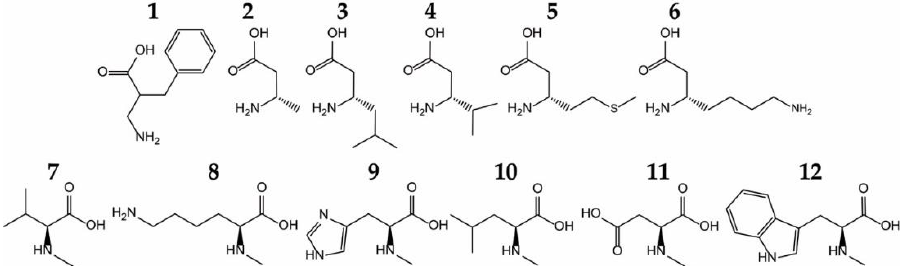
Figure 2. Examples of noncanonical amino acids (ncAAs) acylated by wild-type aaRSs in vitro. Phenylalanyl-tRNA synthetase (PheRS) acylates a β 2 -amino acid, 2-aminomethyl-3-phenyl-propionic acid ( 1 ). Five β 3 -amino acids (Ala ( 2 ), Leu ( 3 ), Val ( 4 ), Met ( 5 ), and Lys ( 6 ), are substrates for